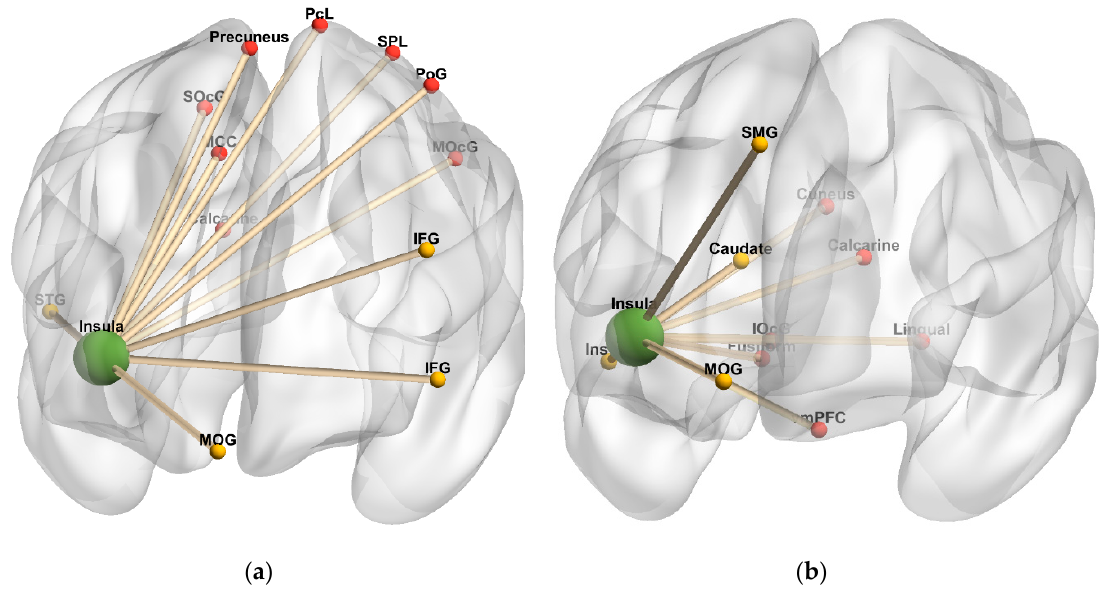
Figure 7. Insula connectivity 3-dimensional rendering. ( a ) Task-independent, fatigue-related connectivity in the healthy control group. ( b ) Task-independent, fatigue-related connectivity in the multiple sclerosis group. The seed is denoted by green spheres; regions with increased connectivity to the seed in the 2-back condition are denoted by yellow spheres, and regions with increased connectivity to the seed in the 0-back condition are denoted by red spheres. Cerebellar regions were omitted. Anterior orientation is in the front of the figure; right hemisphere is on the left side, and left hemisphere is on the right side. Abbreviations: IFG, inferior frontal gyrus. vmPFC, ventromedial prefrontal cortex. SMG, superior medial gyrus. MCC, middle cingulate cortex. PcL, paracentral lobule. PoG, postcentral gyrus. MOG, middle orbital gyrus. STG, superior temporal gyrus. SPL, superior parietal lobule. SOcG, superior occipital gyrus. MOcG, middle occipital gyrus. IOcG, inferior occipital gyrus.